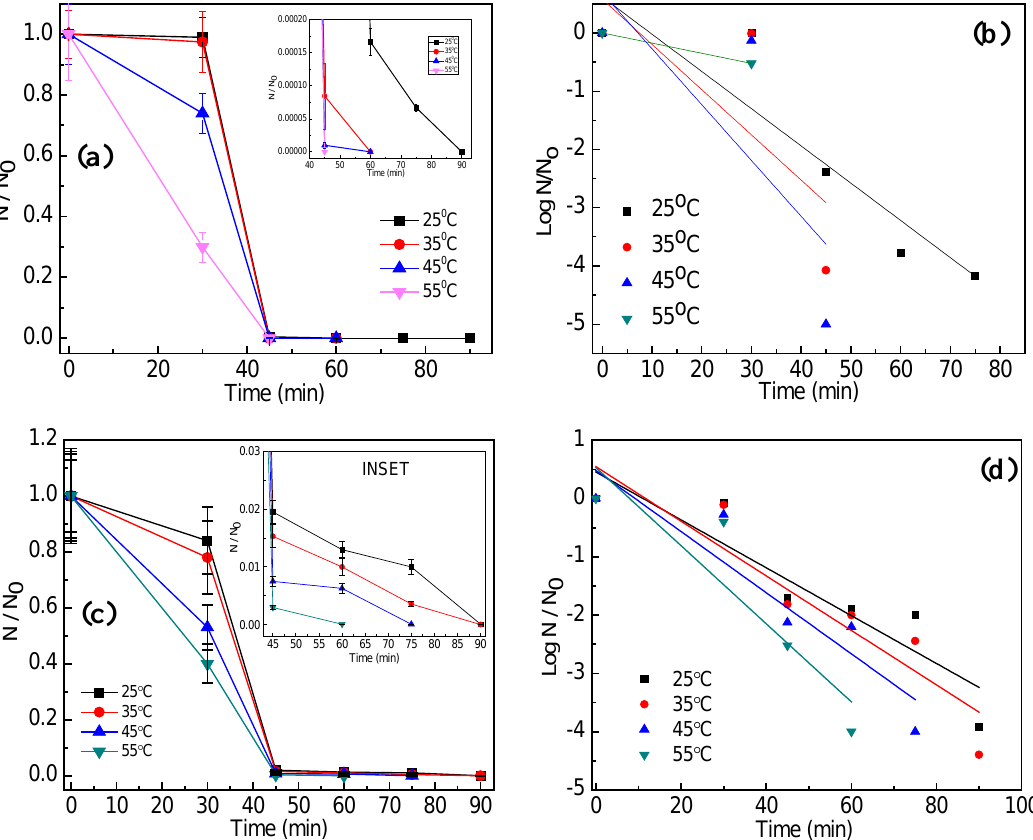
Figure 5. Effect of different reaction temperature on the solar-PCD kinetics of ( a ) E. coli and ( c ) S. aureus at a catalyst loading of 2 mg/L and 3 mg/L respectively. Linear fitting plots of PCD kinetics of different reaction temperature against ( b ) E. coli and ( d ) S. aureus according to Chick-Watson model. Initial bacteria concentration for each experiments = 5 × 10 6 CFU/mL, Error bars indicate the standard deviation of replicates ( n = 3).